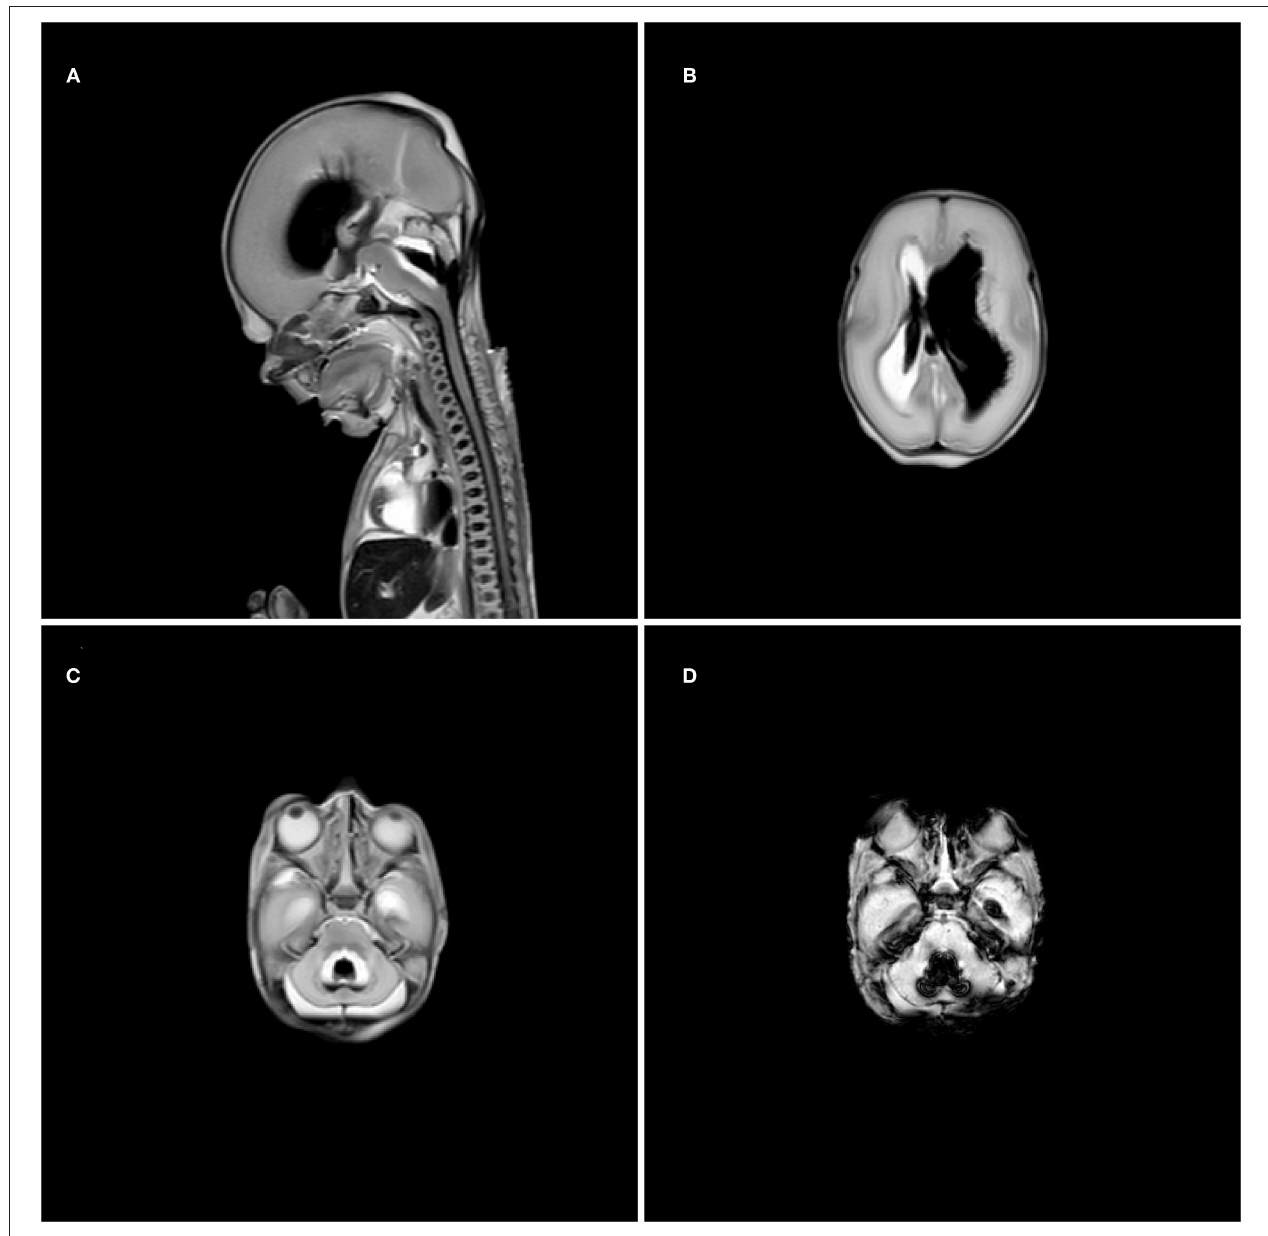
FIGURE 2 | Postmortem magnetic resonance imaging showing extensive ventricular dilatation and blood in the 4 th ventricle in T2-weighted midsagittal plane (A) , intraventricular blood in the right ventricle and ventricular dilatation of the left ventricle in T2-weighted axial plane (B) , blood in the 4 th ventricle with cerebellar dysplasia in T2-weighted axial plane (C) and susceptibility weighted image axial plane (D) of the posterior